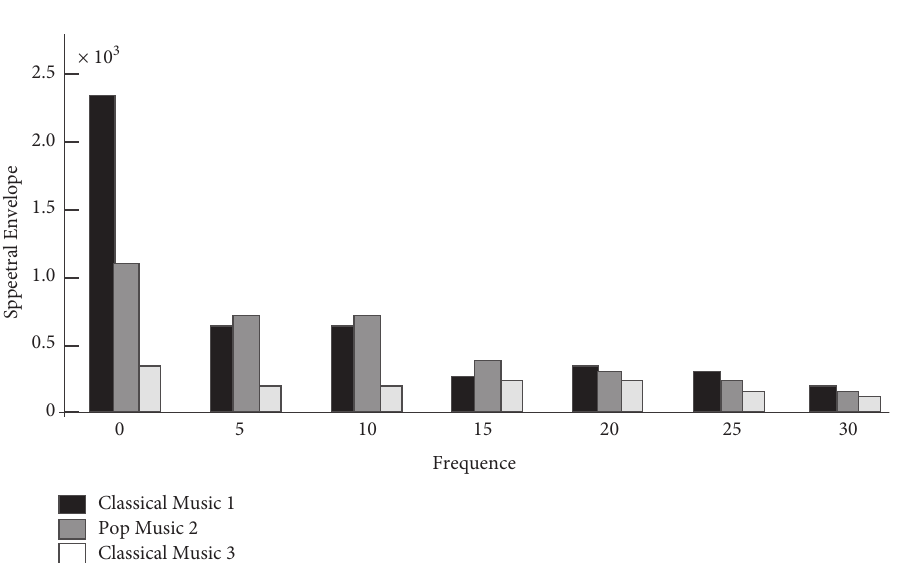
Figure 7: Evaluation results of the method in this